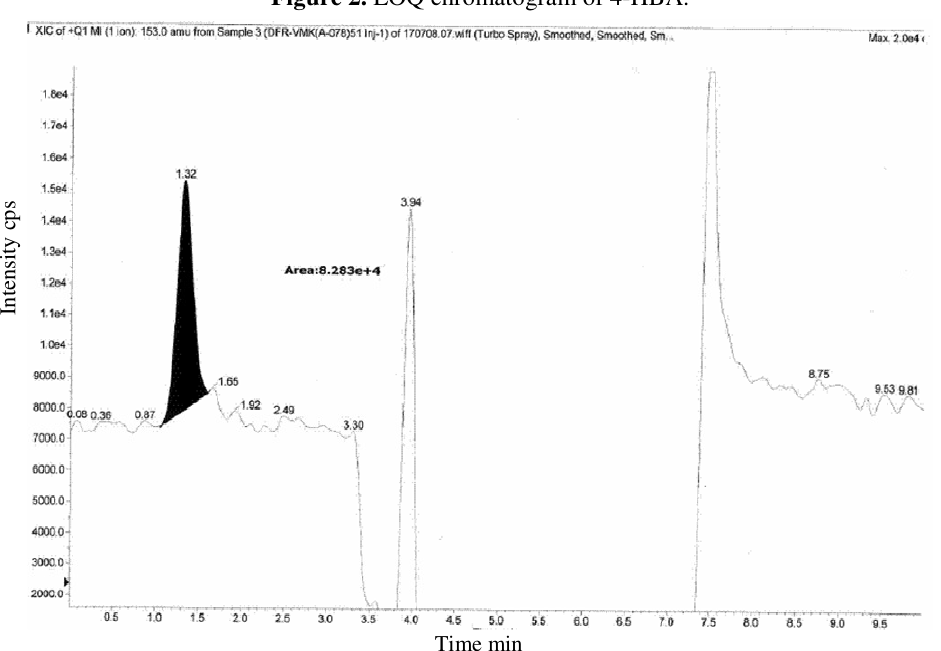
Figure 2. LOQ chromatogram of 4-HBA.